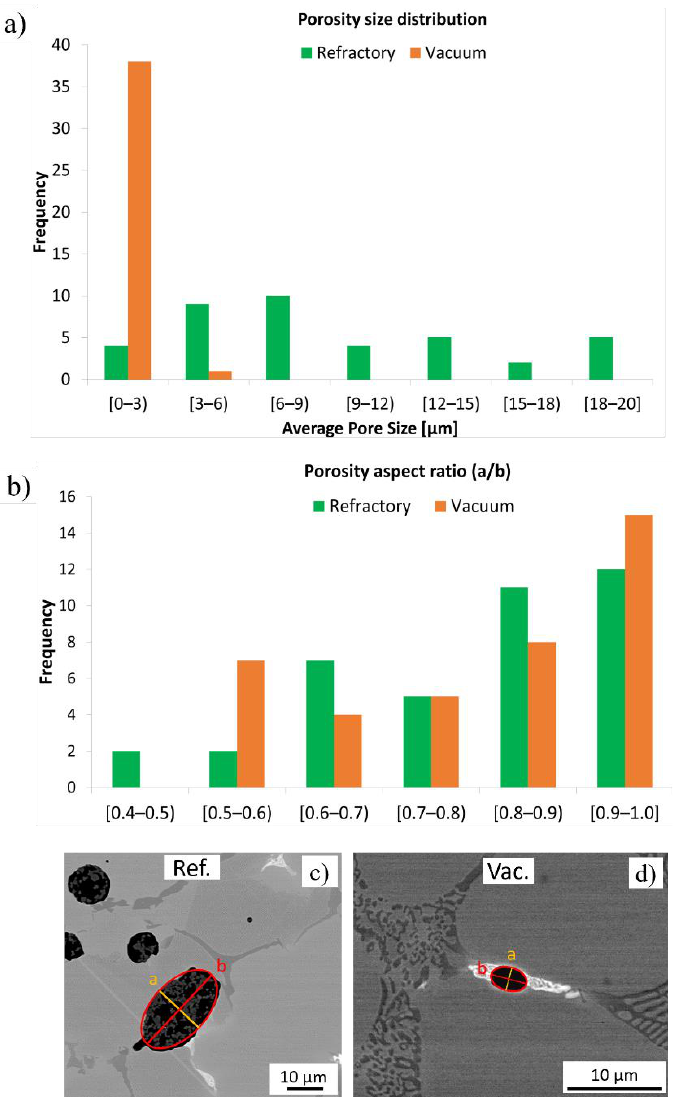
Figure 9. ( a ) Mean porosity size as a function of frequency and ( b ) porosity aspect ratio for the refractory-sintered (green) and vacuum-sintered (orange) specimens. Subfigures ( c , d ) show the shape of the porosities for the refractory ballast and vacuum sintered, respectively, with the measured semi-minor axis, a, and semi-major axis, b, indicated within the micrographs.